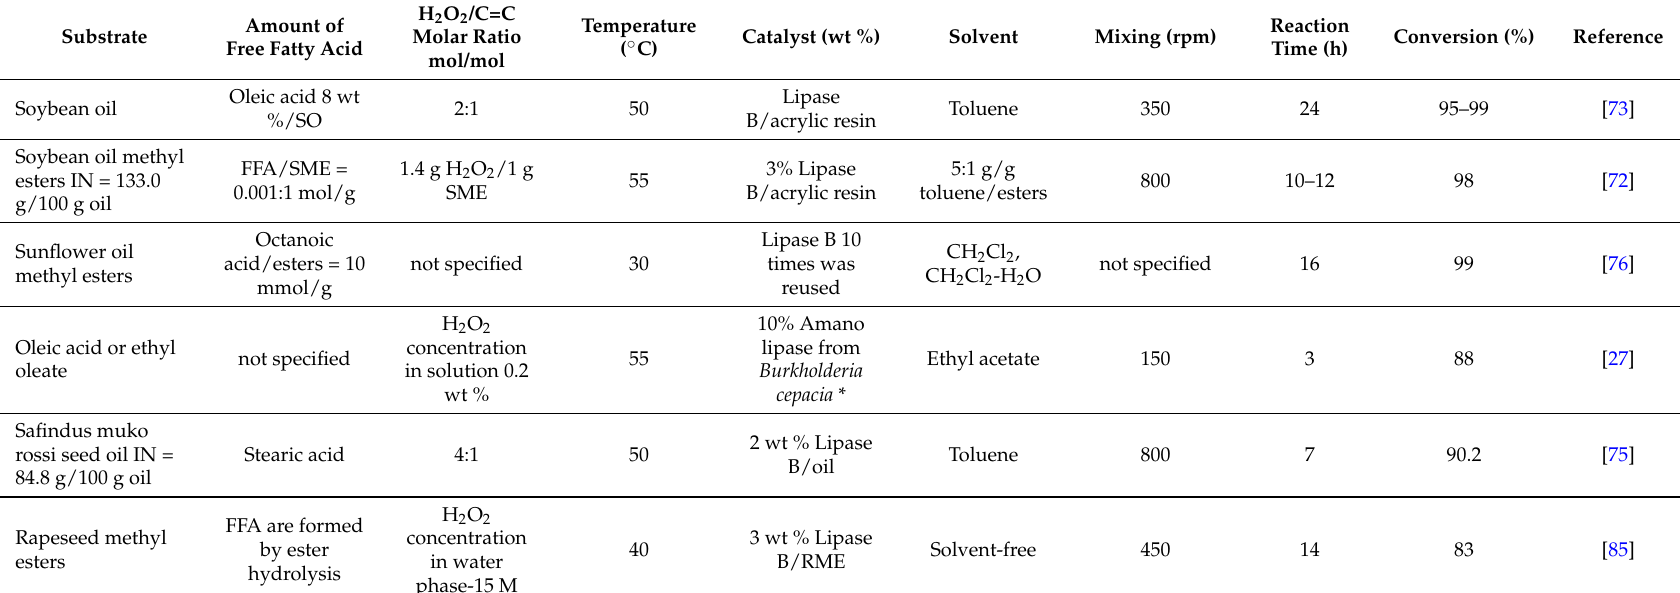
Table 1. Technological parameters chemoenzymatic epoxidation of vegetable oils, free fatty acids and their alkyl